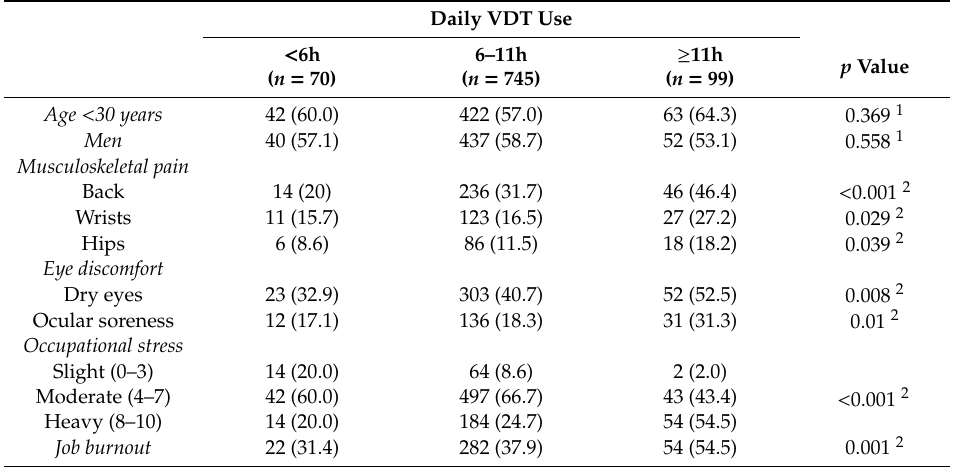
Table 2. Number of participants (%) with health conditions among di ff erent durations of daily VDT use.